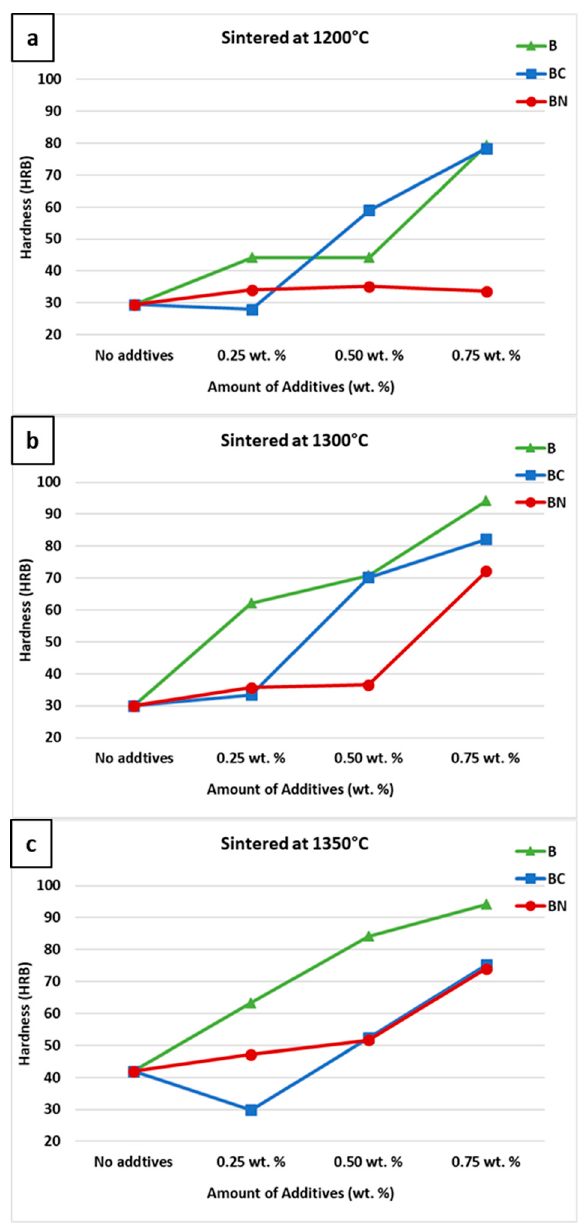
Figure 20. Hardness of samples with different amount of additives sintered at ( a ) 1200 °C, ( b ) 1300 °C, and ( c ) 1350 °C.